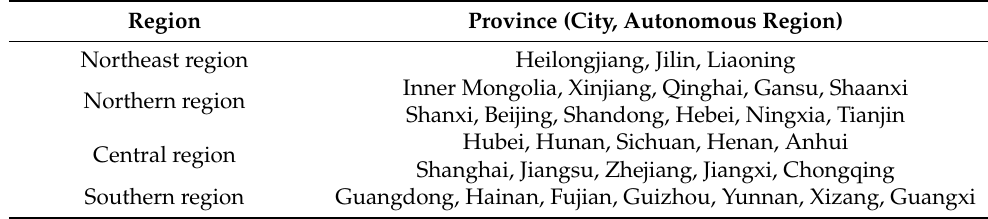
Table A2. The specific division of the four major regions.